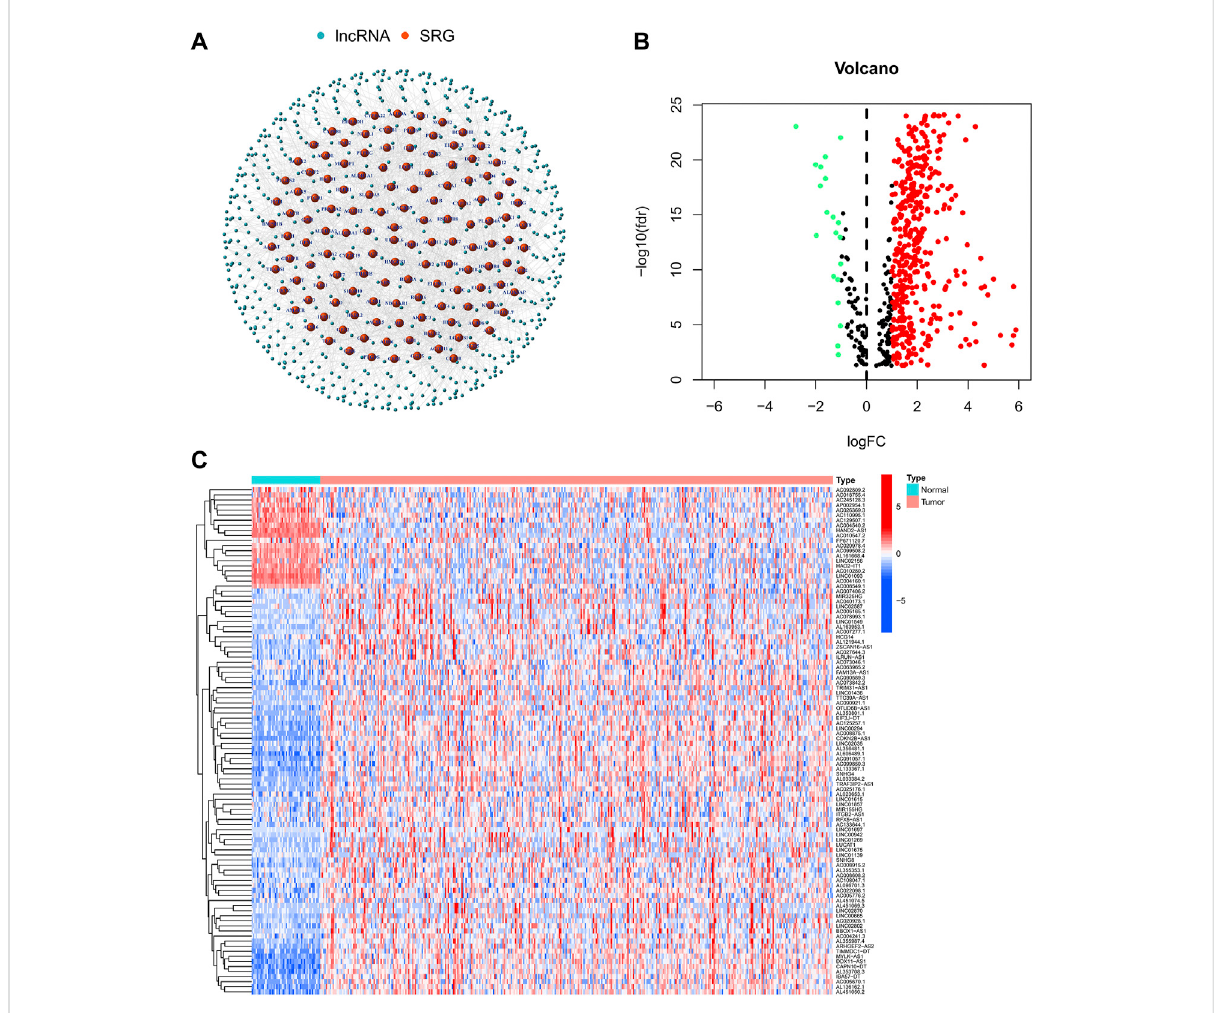
FIGURE 2 (A) The network showing the correlation between DEsrlncRNAs and mRNAs and (B,C) the heatmap and volcano plots of DEsrlncRNAs from the TCGA